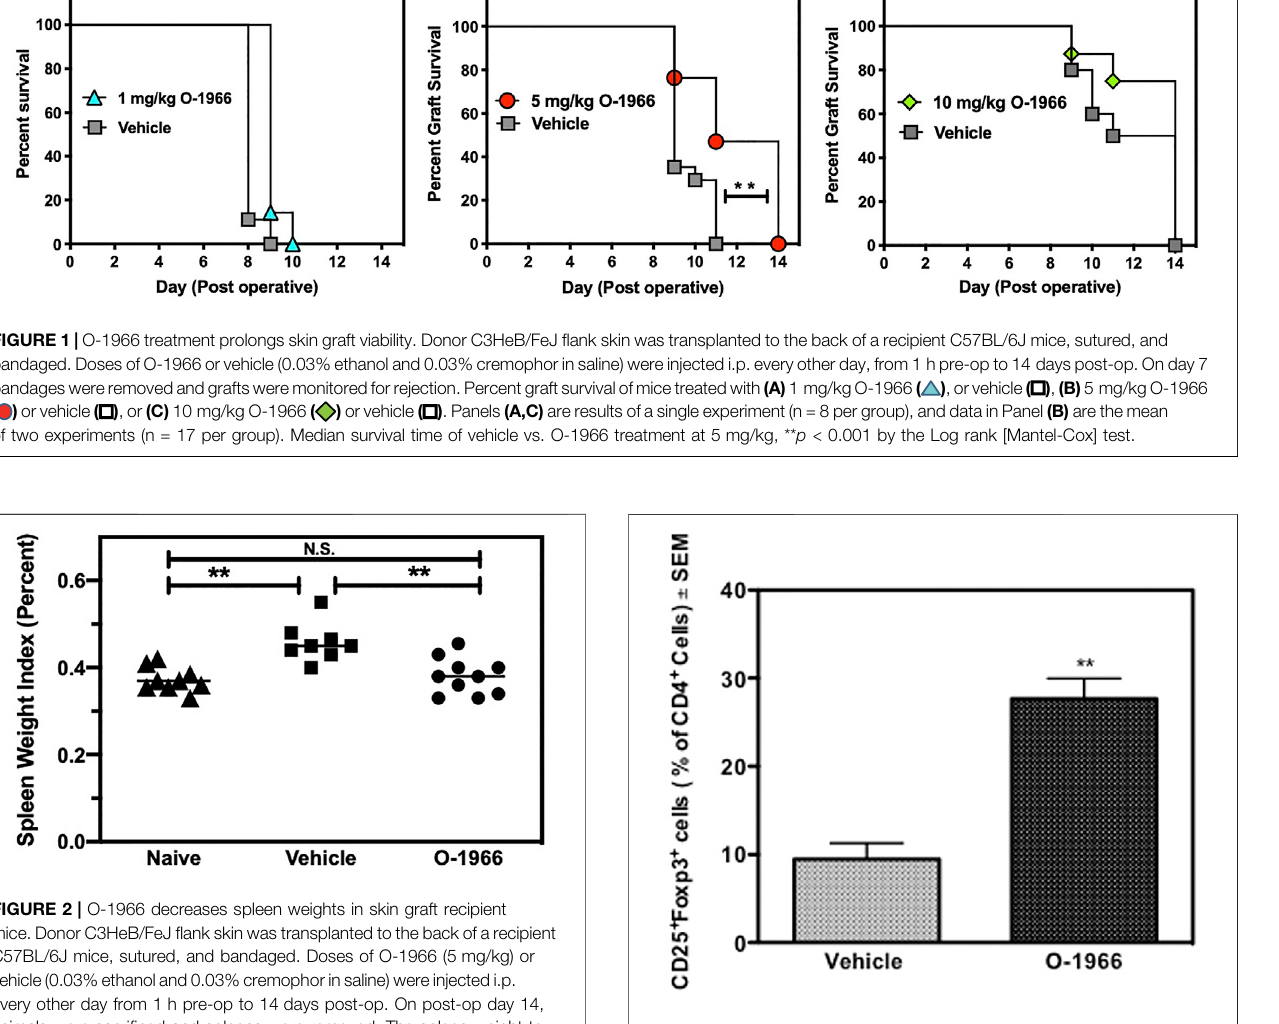
FIGURE 3 | O-1966 treatment increases percentage of splenic Tregs in skin graftrecipient mice. DonorC3HeB/FeJ fl ankskin wastransplantedto the back of recipient C57BL/6J mice, sutured, and bandaged. Doses of O-1966 (5 mg/kg) or vehicle (0.03% ethanol and 0.03% cremophor in saline) were injected i.p. every other day from 1 h pre-op to 14 days post-op. Splenocytes were harvested from grafted mice treated with O-1966 ( ) or vehicle ( ) on day 14 and were analyzed by fl ow cytometry for CD4 + CD25 + FoxP3 + Tregs (n (cid:1) 17 for both groups). Data show number of Tregs as a percentage of total live CD4 + cells (LIVE/DEAD ® dead cell stain negative). Data are mean of two separate experiments. ** p < 0.01 for O-1966 vs. vehicle as determined by one-way ANOVA followed by Tukey ’ s multiple comparison